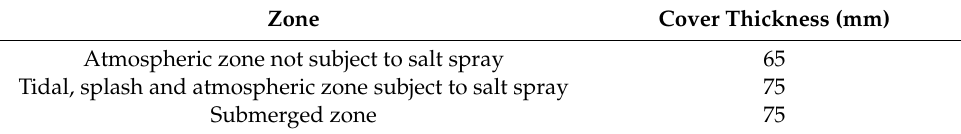
Table 2. Cover requirements from NAVFAC [30] marine concrete specification.